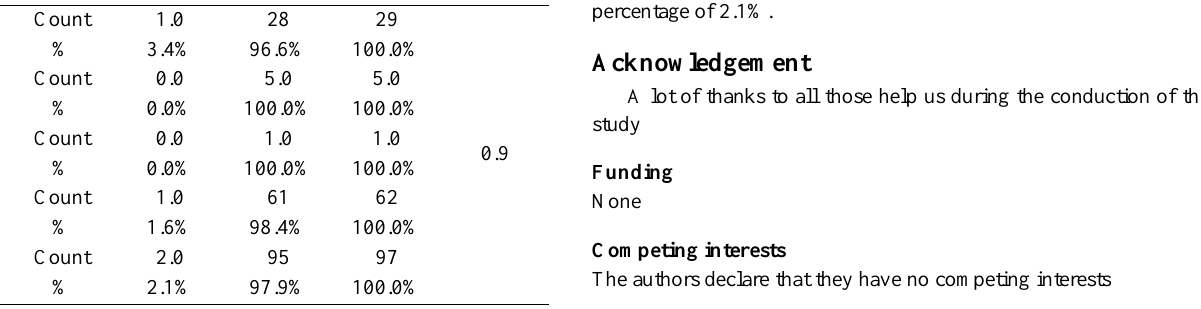
Table 4 : Correlation between PCR results and miscarriages